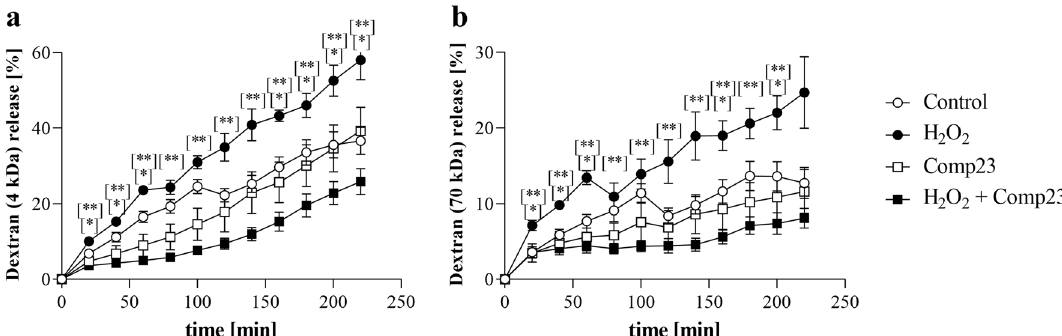
Figure 6. Effect of PARK7-binding Comp23 on the intestinal permeability of WT mice. Mucosal permeability of colon sacs derived from control and Comp23 pretreated WT mice, filled with fluorescence dextrans (4 kDa ( a ) and 70 kDa ( b )) diluted in DMEM were investigated in the absence or presence of H 2 O 2 (1000 μM). Permeation of dextrans were measured in every 20 min for 4 h. Results are presented as the percent of total release and illustrated as mean ± SEM. Analysis of significance was performed by two-way ANOVA test. *p < 0.05 Control vs . H 2 O 2 ; **p < 0.05 H 2 O 2 vs . Comp23 + H 2 O 2 at given